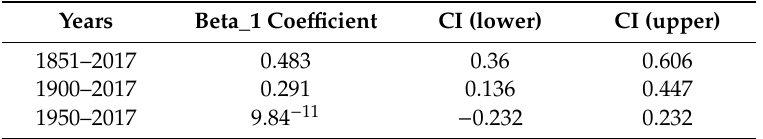
Table 4. Time series count model coe ffi cients and confidence intervals within a Poisson